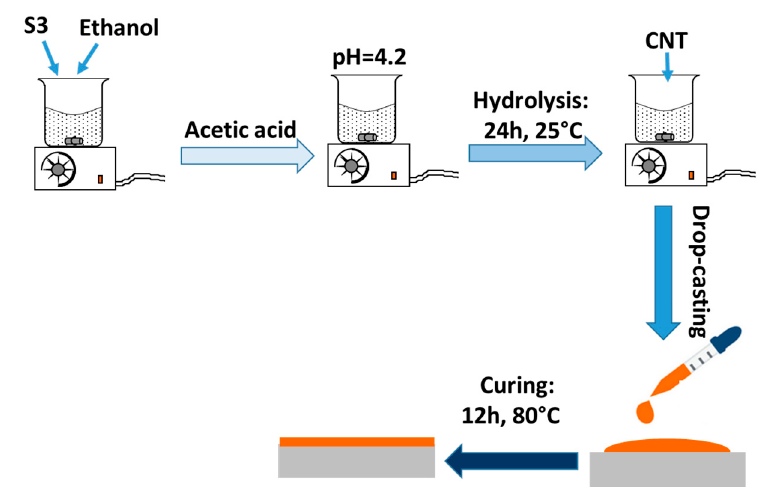
Figure 1. Scheme of the four step carbon nanotubes (CNT) coating process deposition. Table 1. Samples summary. Sample codes, filler content, matrix, and coating specification.